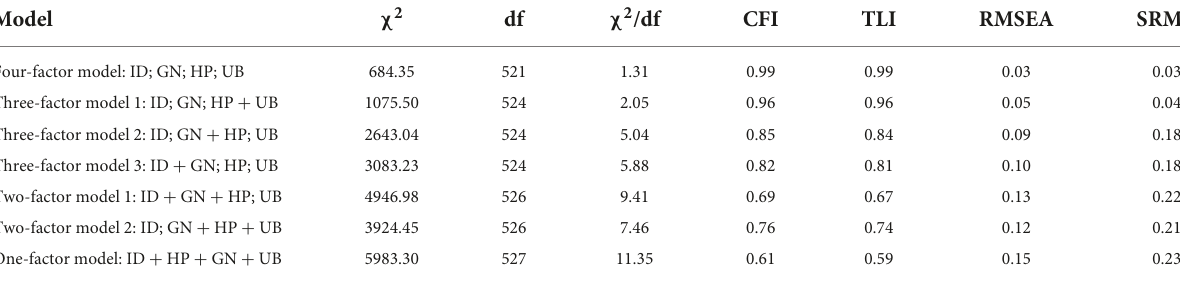
TABLE 2 Results of confirmatory factor analysis ( N =